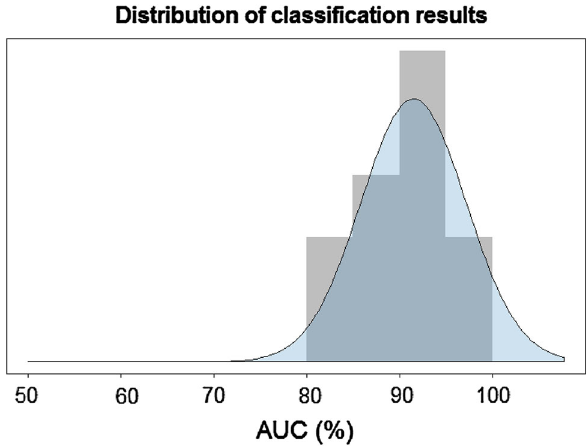
Fig. 2 Distribution of the 12 AUC scores measured on the outer validation set of the Monte Carlo cross-validation (MCCV) around the mean score of